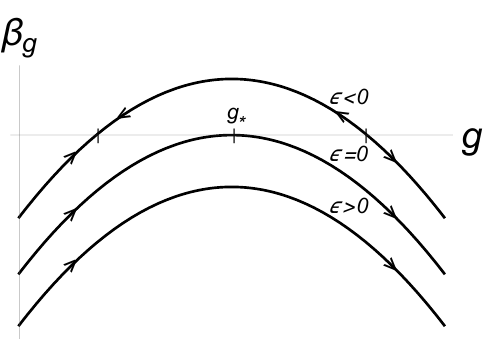
Figure 1 . Beta function of the coupling g for di(cid:11)erent values of (cid:15) . For (cid:15) = 0, the IR and UV (cid:12)xed points merge at g (cid:3)